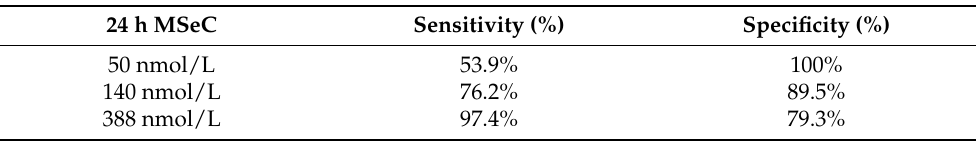
Table 3. Sensitivity and specificity of morning serum cortisol collected 24 h after TSS assessment, depending on its threshold levels in predicting CD remission after TSS.